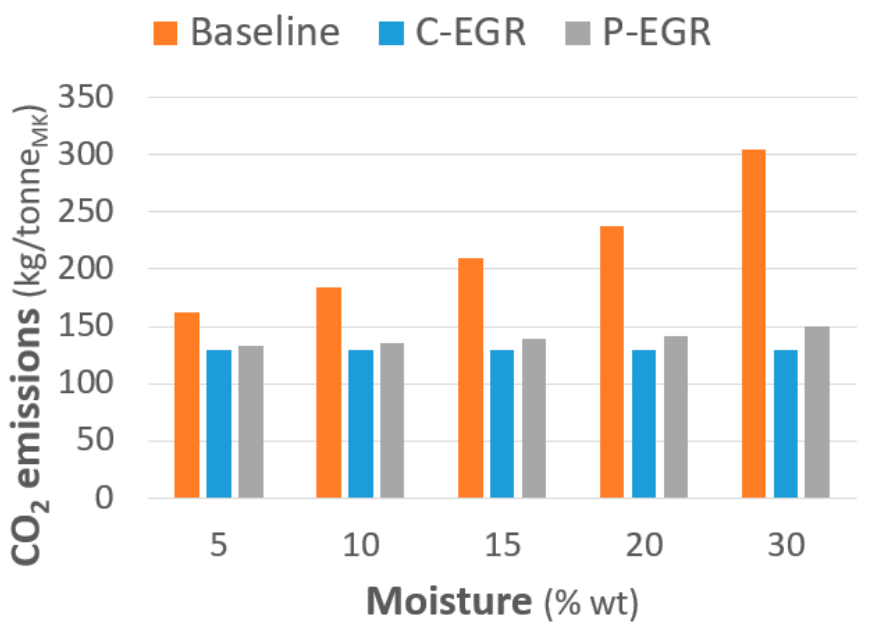
Figure 7. Calculated MK production process CO 2 emissions (MWh/tonne MK ). Impact of raw material moisture content. (Fuel: NG; reference kiln temperature: 750 °C).